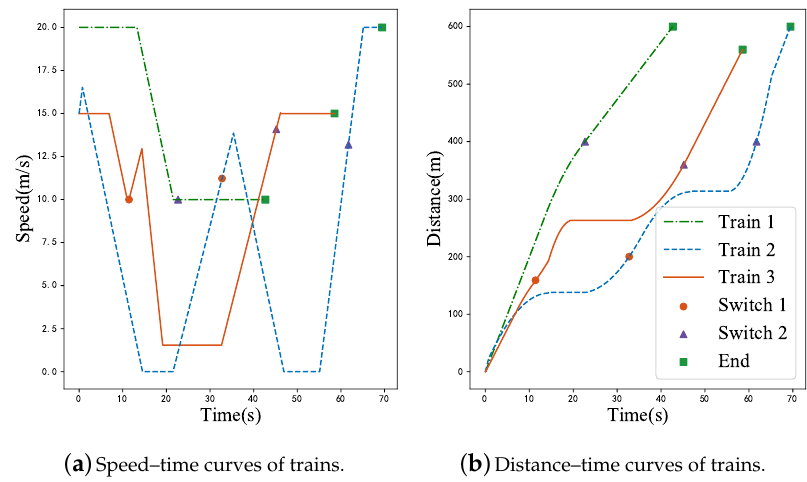
( a ) Speed–time curves of trains. ( b ) Distance–time curves of trains. Figure 4. Trains operation curves of naive strategy 2 in scenario 1.